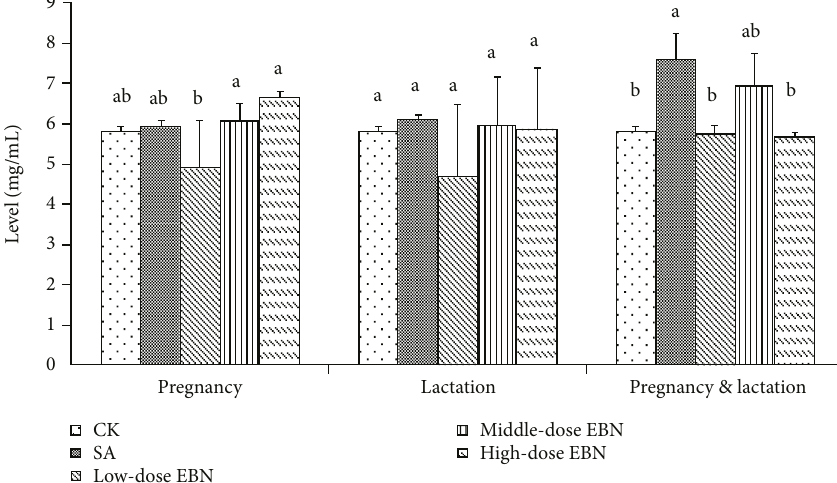
Figure 3: Comparison of protein-bounded sialic acid (PSA) level in mouse milk from each group of 10 female mice administrated with EBN. Signi fi cant di ff erences were indicated by di ff erent letters for each group ( P < 0 05